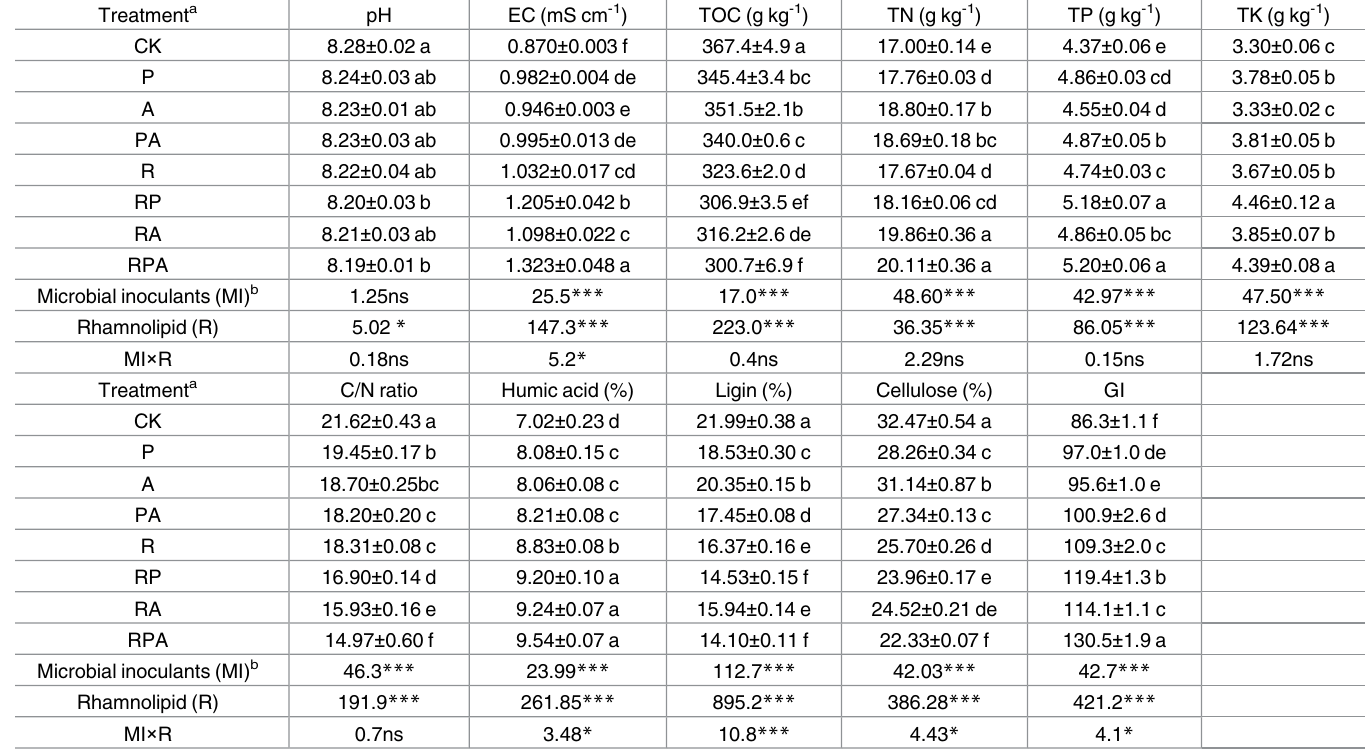
Table 4. Effects of the microbial inoculants and rhamnolipid on the chemical properties of vermicompost. Treatment a